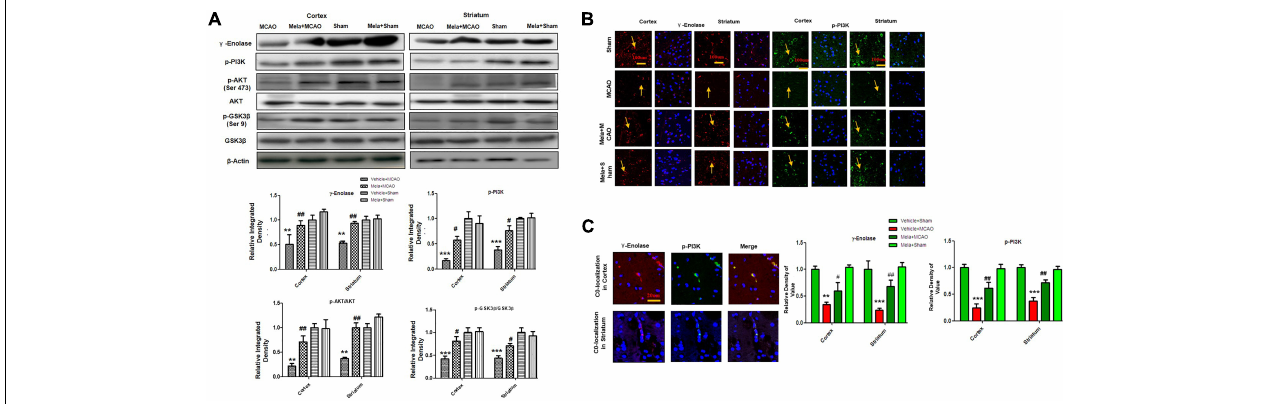
FIGURE 4 | Melatonin induces neuroprotection via PI3K/AKT/GSK-3 β /CRMP2 pathway. (A) Western blot analysis of γ –enolase, p-PI3K, p-Akt, Akt, p-GSK-3 β , GSK-3 β , CRMP2, p-CRMP2 from cortical, and striatal tissues ( n = 7 rats/group). The bands were quantified using ImageJ, analyzed by graph-pad prism-5 software. β -actin was used as control. Densitometric analysis was expressed in arbitrary units as the mean ± SEM for the indicated proteins. (B) Immunofluorescence reactivity of γ -enolase and p-PI3K; ( n = 7 rats/group). The above data is representation of 3 numbers of experiments. Scale bar = 100 µ m and magnification 40 × (A) γ -enolase (B) p-PI3K show cytoplasmic localization and was visualized by TRITC and FITC. (C) Double immunofluorescence of γ -enolase and p-PI3K in ischemic brain. The cortical and subcortical sections show correspondingly decreased expression of γ -enolase and p-PI3K after 24 h of permanent ischemia. γ -enolase visualized by TRITC and p-PI3K was by FITC. Symbol # represent significant difference values p < 0.05, while symbols ∗∗ and ## represent p < 0.01 values for significant differences, symbol ∗∗∗ shows p < 0.001. Symbol ∗ shows significant difference relative to sham control while # shows significant difference relative to